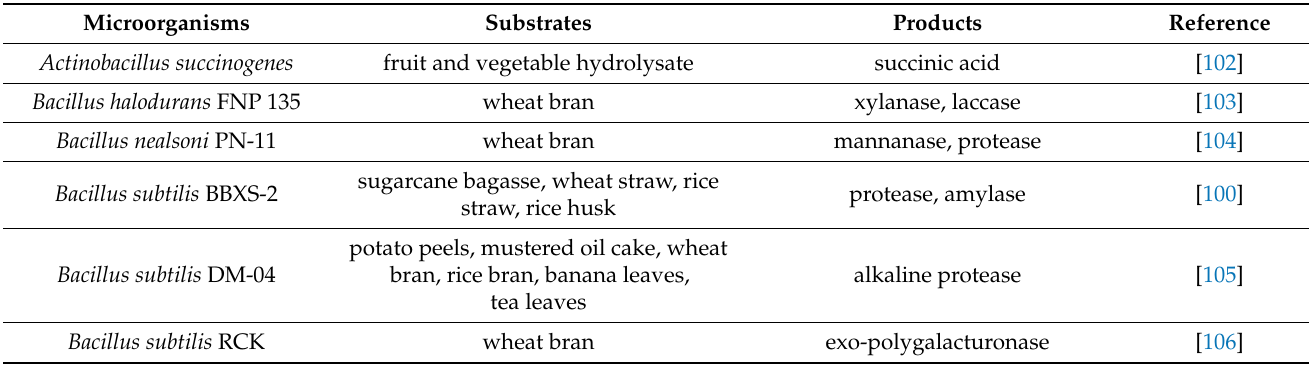
Table 4. Bacteria used in SSF for production of different